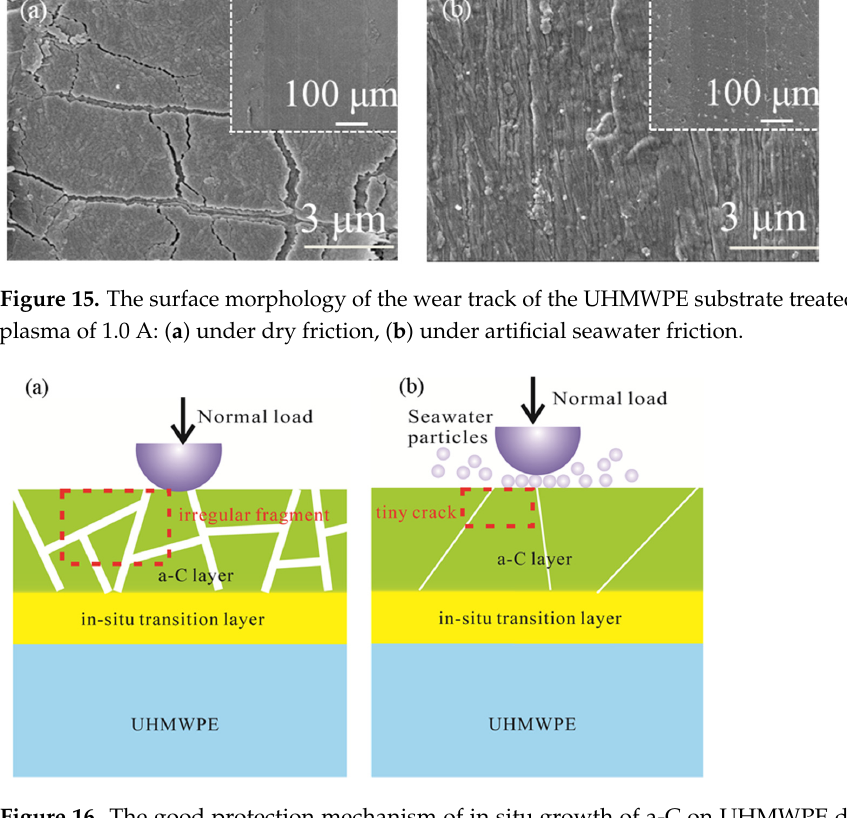
Figure 15. The surface morphology of the wear track of the UHMWPE substrate treated with car- bon plasma of 1.0 A: ( a ) under dry friction, ( b ) under artificial seawater friction.